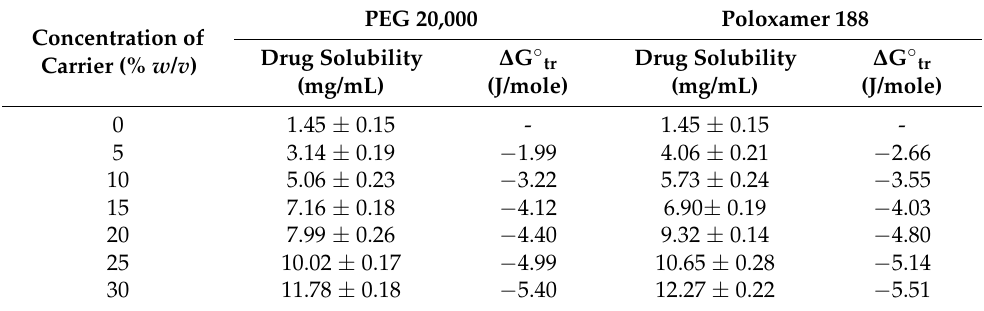
Table 1. Phase solubility and Gibbs-free energy of transfer ( ∆ G ◦ tr ) of fexofenadine hydrochloride in different concentrations of PEG 20,000 and poloxamer 188 water systems at 37 ± 0.5 ◦ C (Mean ± SD, n =